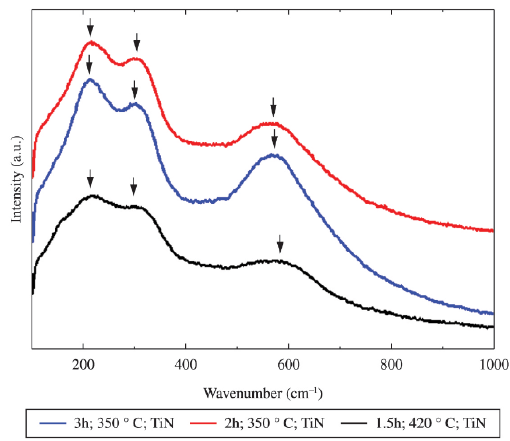
Figure 2. Raman spectra of titanium double cathode cage deposited samples at 350 and 420ºC and 1,5, 2 and 3 treatment time.